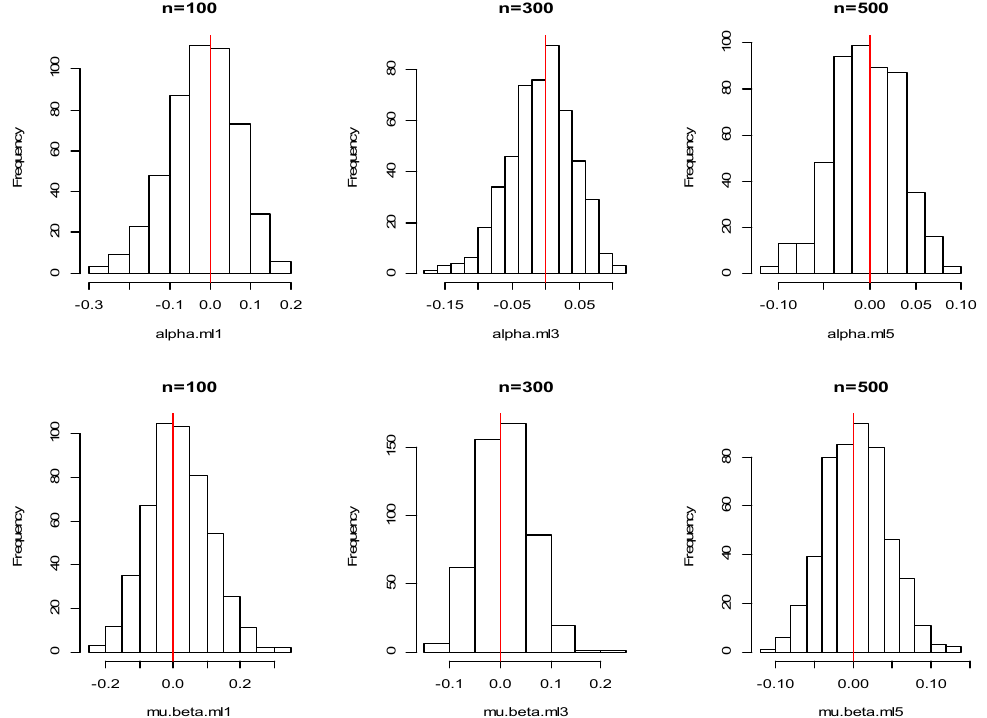
Figure 8. Histogram of estimated parameter α and µ β with maximum likelihood method in Case 1.